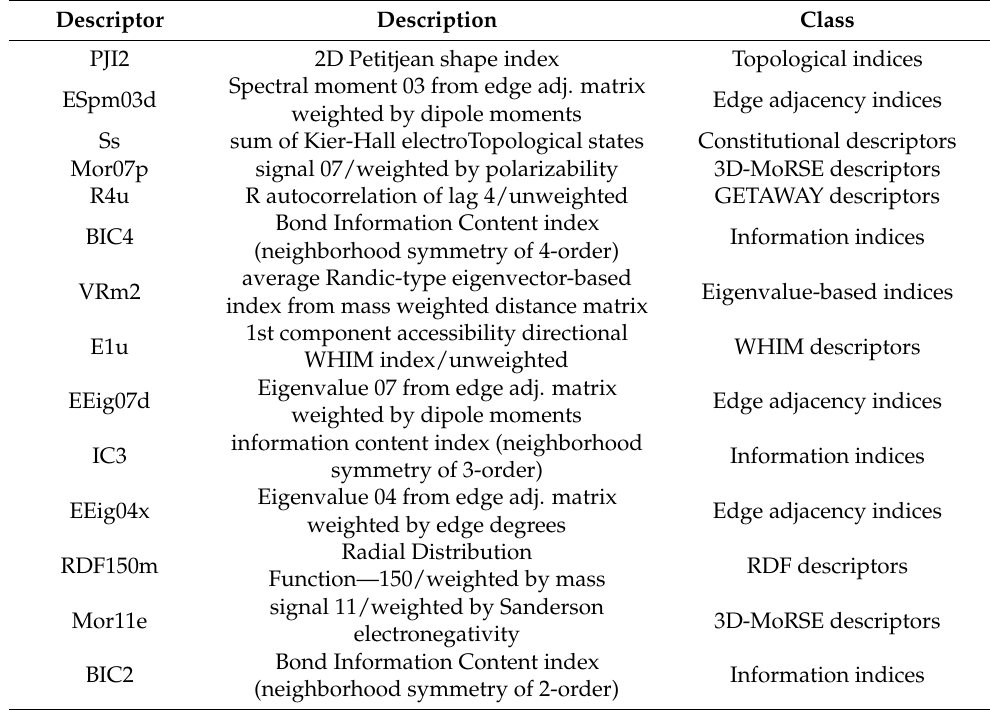
Table 5. Description of 14 descriptors in